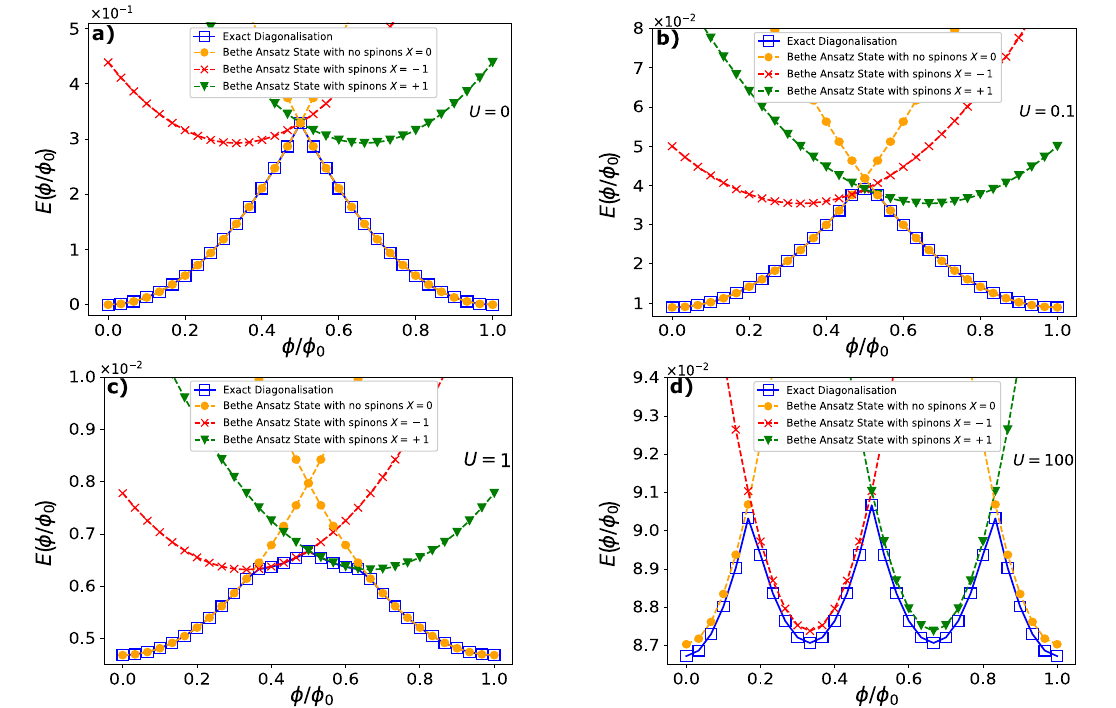
Figure 5: Spinon creation in incommensurate SU( N ) fermionic systems. The case of = 3 fermions residing on a ring composed of L = 30 sites. N = 3 is considered for N p The above figures show how the Bethe ansatz energies need to be characterized by spinon quantum numbers in order to have the actual ground state for various values of the interaction U . All curves are calculated with the Bethe ansatz of the Gaudin- Yang-Sutherland model and exact